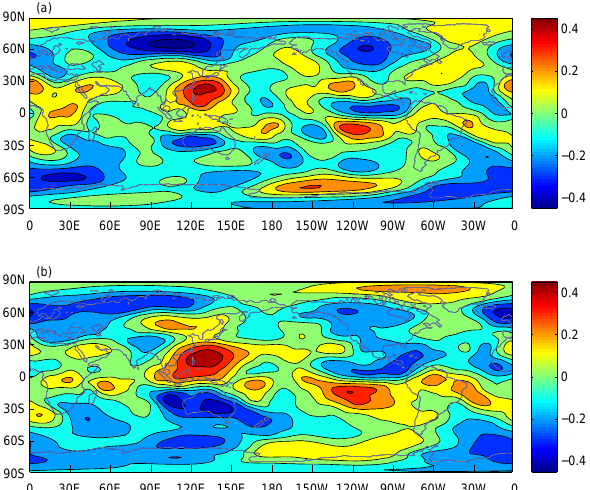
Figure 5. Lag correlation maps (lag day = 15 days) of the north- ern SCS (110–121 ◦ E, 12–23 ◦ N) SST anomalies in winter (October 2003–March 2004) with global barotropic stream function (a) and baroclinic stream function (b) .